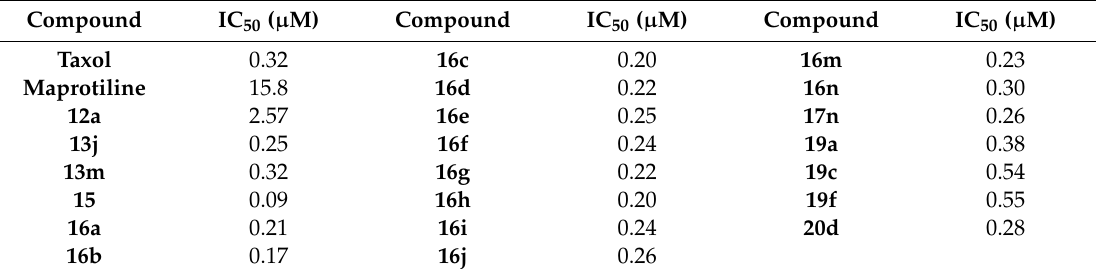
Table 10. IC 50 values for selected ethanoanthracenes in the MUTU-I cell line (24 h) a . Compound IC 50 ( µ M) Compound Maprotiline